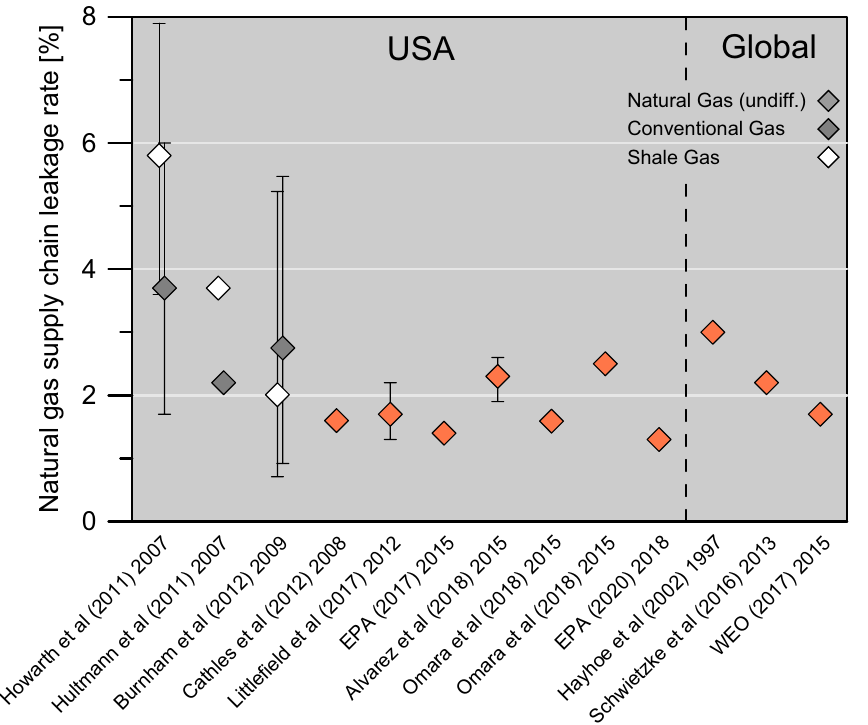
Figure 3. Literature compilation of methane leakage rate assessments with U.S. national and global scope, chronologically ordered. If reported, emissions are differentiated for conventional or shale gas and error bars are given (detailed listing see Supplementary Table S3). Next to the publication year the dataset year is given. Omara et al. 15 report exclusively on production losses—thus, for comparison, downstream emissions of 1% 14 ) were